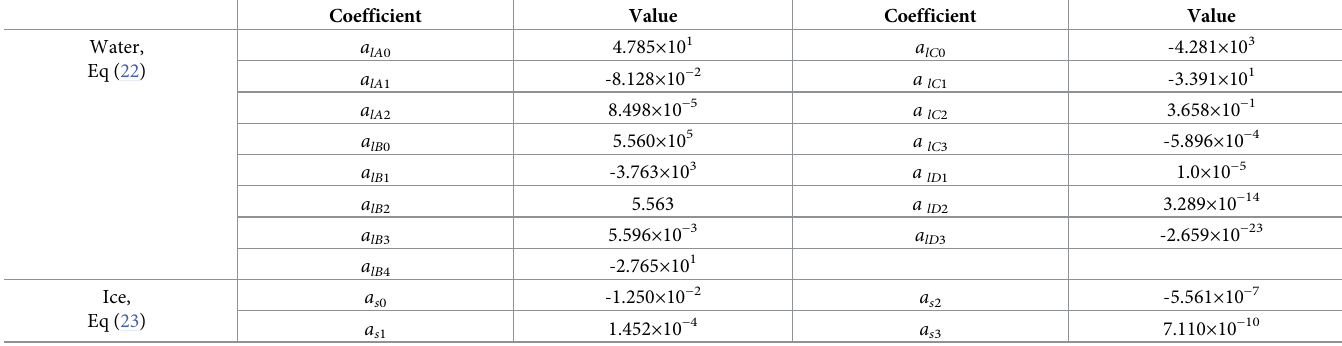
Table 2. Coefficients for thermal expansion of water and ice, Eqs (22) and